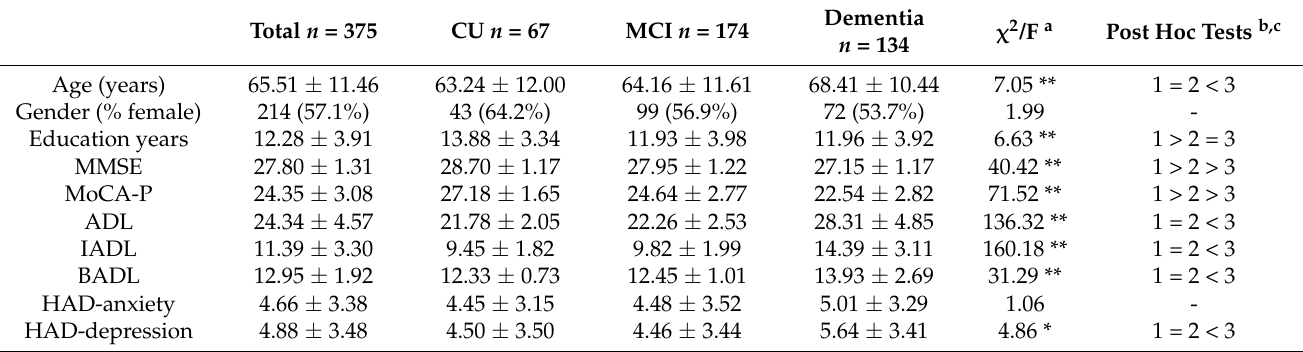
Table 1. Comparison of demographic details and cognitive data among the